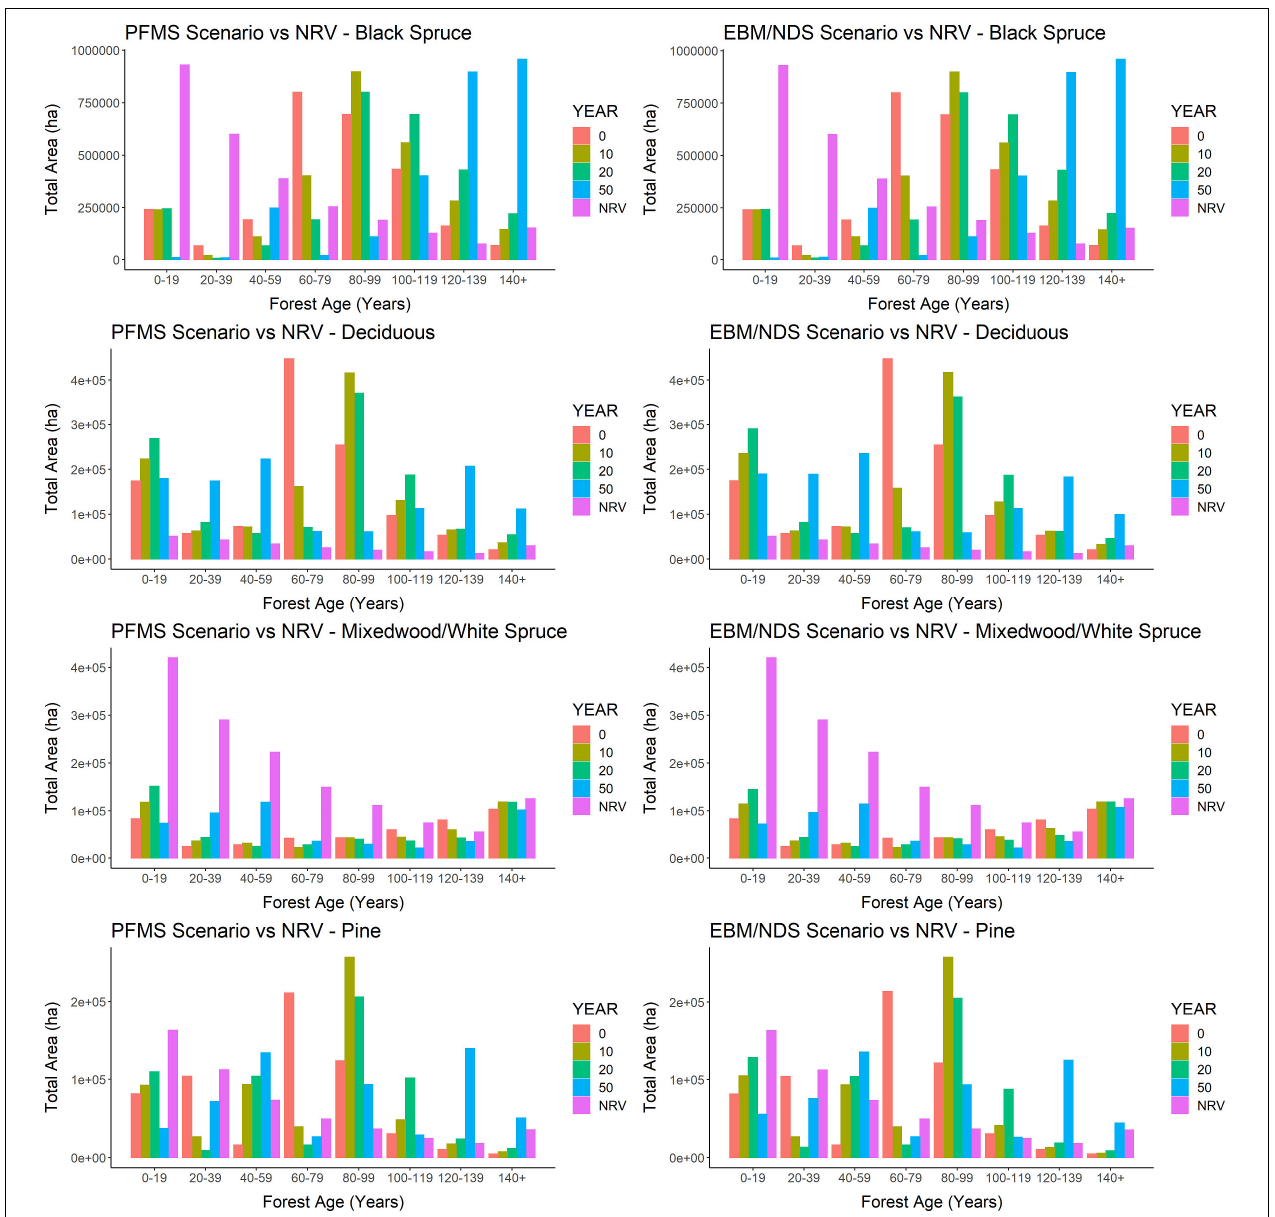
FIGURE 9 | Predicted amounts of different forest age-classes over time (year 0–50, where year 0 = 2016) totaled for the Al-Pac Forest Management Area, under two scenarios: (1) the Preferred Forest Management (PFM) scenario that included harvest deferral within caribou habitats (green line); and (2) the Ecosystem-Based Management/Natural Disturbance Model (EBM) scenario without harvest deferral (blue), relative to the median amount of those forest age-classes predicted from the Natural Range of Variation (NRV) Scenario in the absence of human footprint. (1) Forest types 0–9 and 10–19 years old were treated separately when predicting bird abundance but were combined to simplify display in these plots; (2) Mixed-wood and white spruce were treated separately when predicting bird abundance in the Patchworks scenarios but were combined in these plots for comparison against the NRV Scenario. The reason for doing so is that so little pure white spruce occurred in simulations of the NRV Scenario that white spruce was treated as older mixed-wood forests when predicting bird